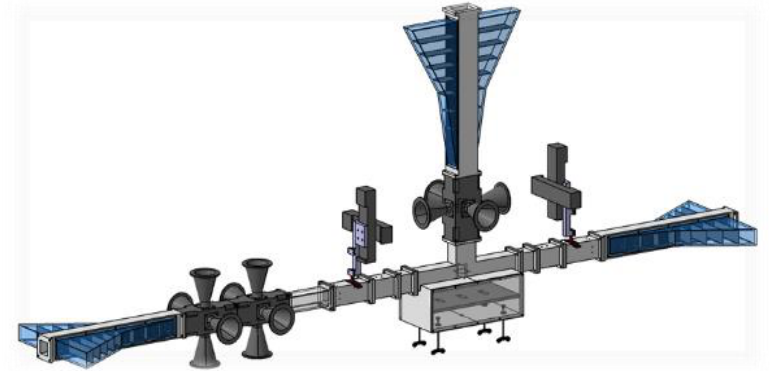
Figure 4. Schematic of in-situ method setup.